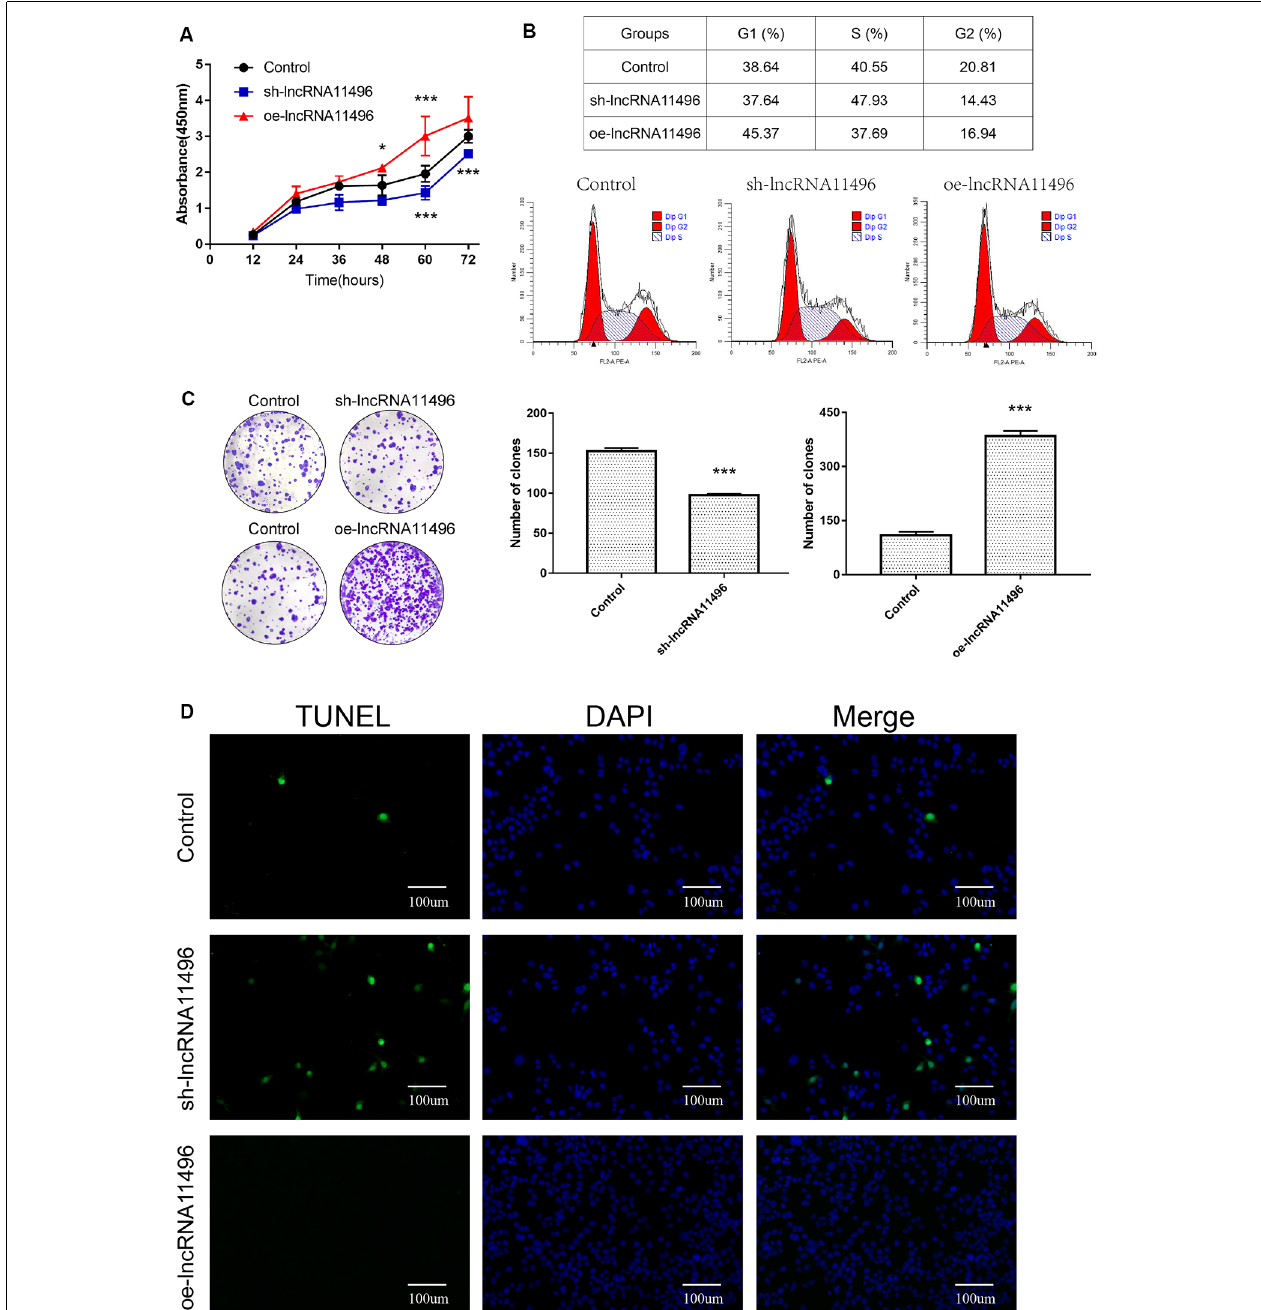
FIGURE 6 | lncRNA11496 affects proliferation, differentiation and apoptosis of BV-2 cells. (A) Cell proliferation was determined by CCK-8 assay which was performed in BV-2 cells transfected with sh-lncRNA11496 or oe-lncRNA11496 12 h, 24 h, 36 h, 48 h, 60 h, 72 h later. All values are presented as mean ± SD for three independent experiments (* P < 0.05, *** P < 0.001, student’s t -test). (B) The cell cycle of BV-2 cells transfected with sh-lncRNA11496 or oe-lncRNA11496 was analyzed by Flow cytometry. (C) The forming colony was verified in BV-2 cells transfected with sh-lncRNA11496 or oe-lncRNA11496. All values are presented as mean ± SD for three independent experiments (*** P < 0.001, student’s t -test). (D) Cell apoptosis of BV-2 cells transfected with control plasmid, sh-lncRNA11496 and oe-lncRNA11496 was analyzed by Tunel assay. Cell apoptosis was detected using TUNEL assay kit. DAPI (blue) was used for counterstaining. The coverslips were observed and images are collected by Fluorescent Microscopy. Apoptosis cells labeled with FITC show green fluorescence.